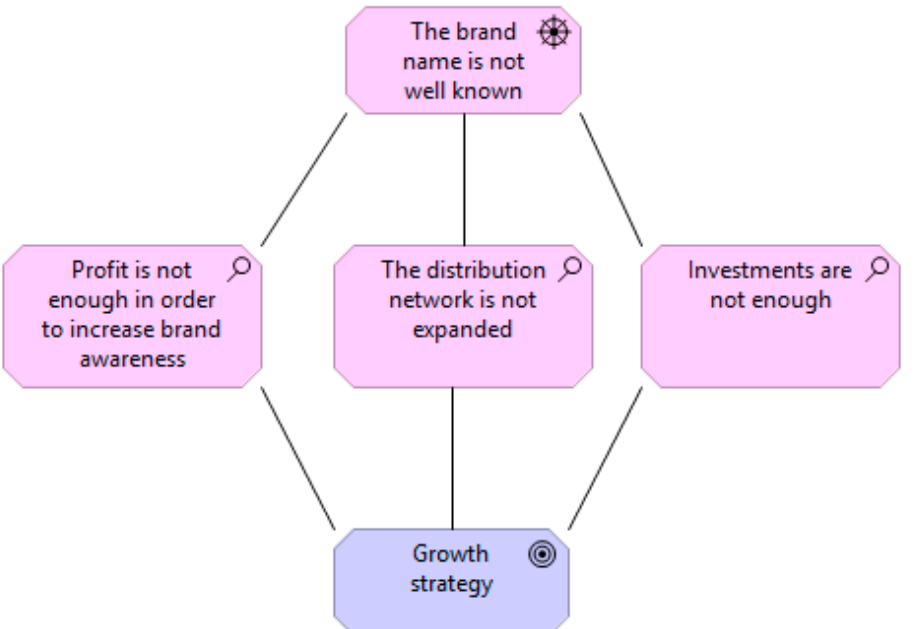
Figure 10. Formulation of the business strategy, based on drivers and assessments.